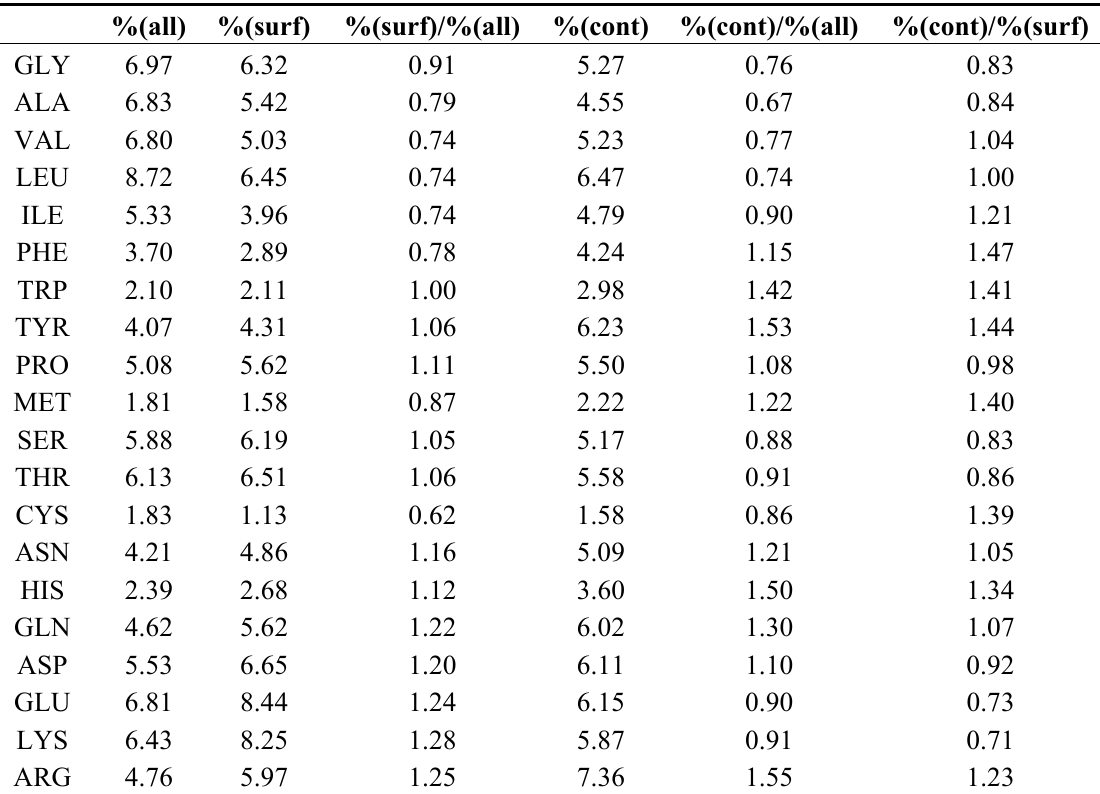
Table 1. Residue propensities to appear (all), be on the surface (surf) or form contact